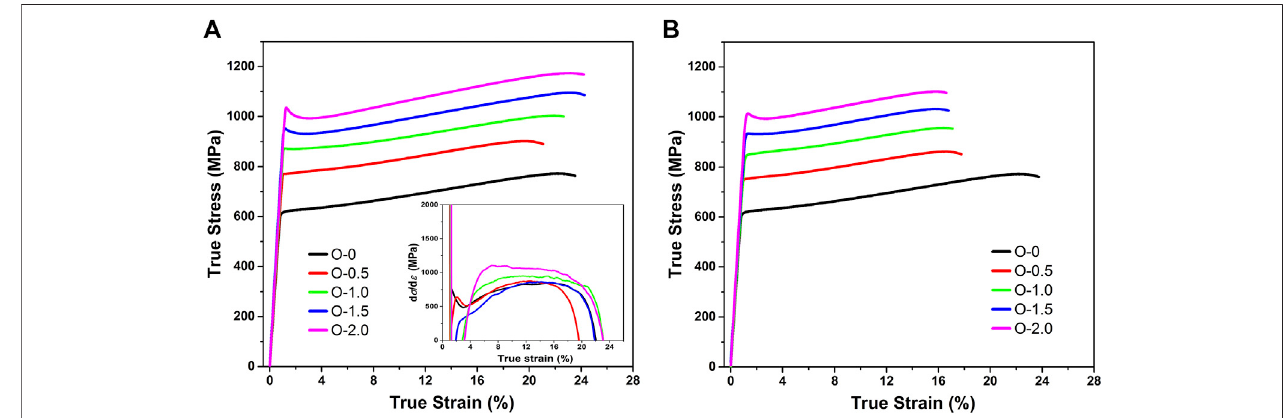
Frontiers in Materials |